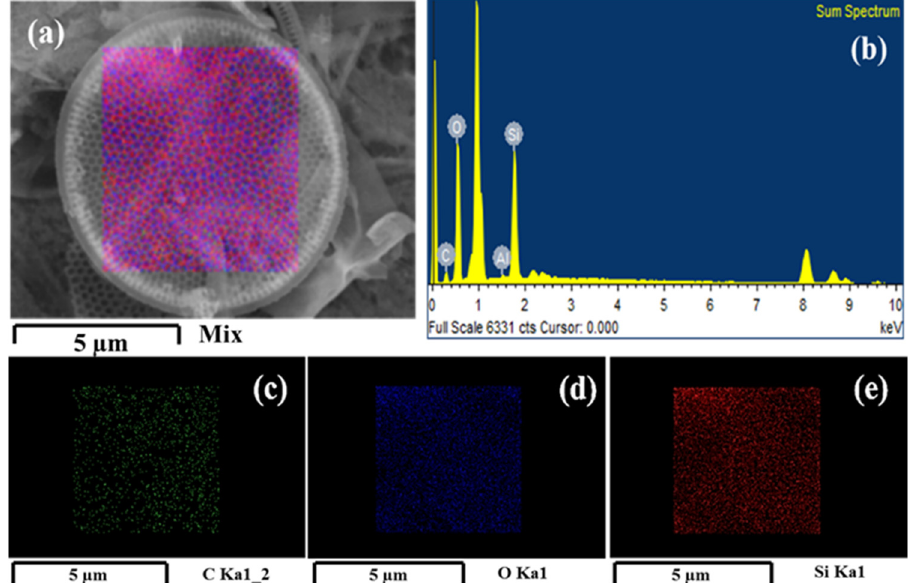
Figure 9. SEM-EDS imaging and surface elemental mapping of diatomite frustules. ( a ) Mapping of silica frustules; ( b ); EDS spectrum; ( c – e ) elemental distribution mapping for carbon, oxygen, and silicon on silica frustules, respectively.